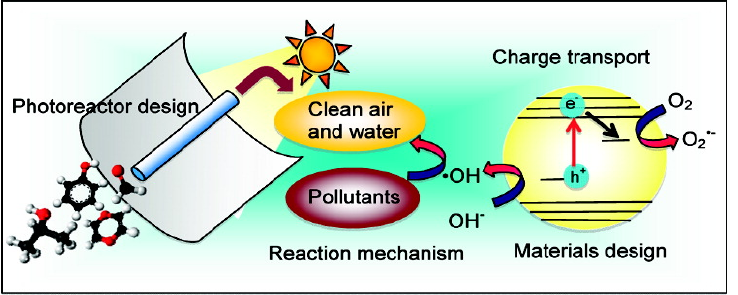
Figure 2. Schematic of the interplay of photocatalysis treatment, reactor and material design and photocatalytic reaction mechanism [1]. Note: This figure is reproduced with permission from [1], Copyright © 2012 American Chemical